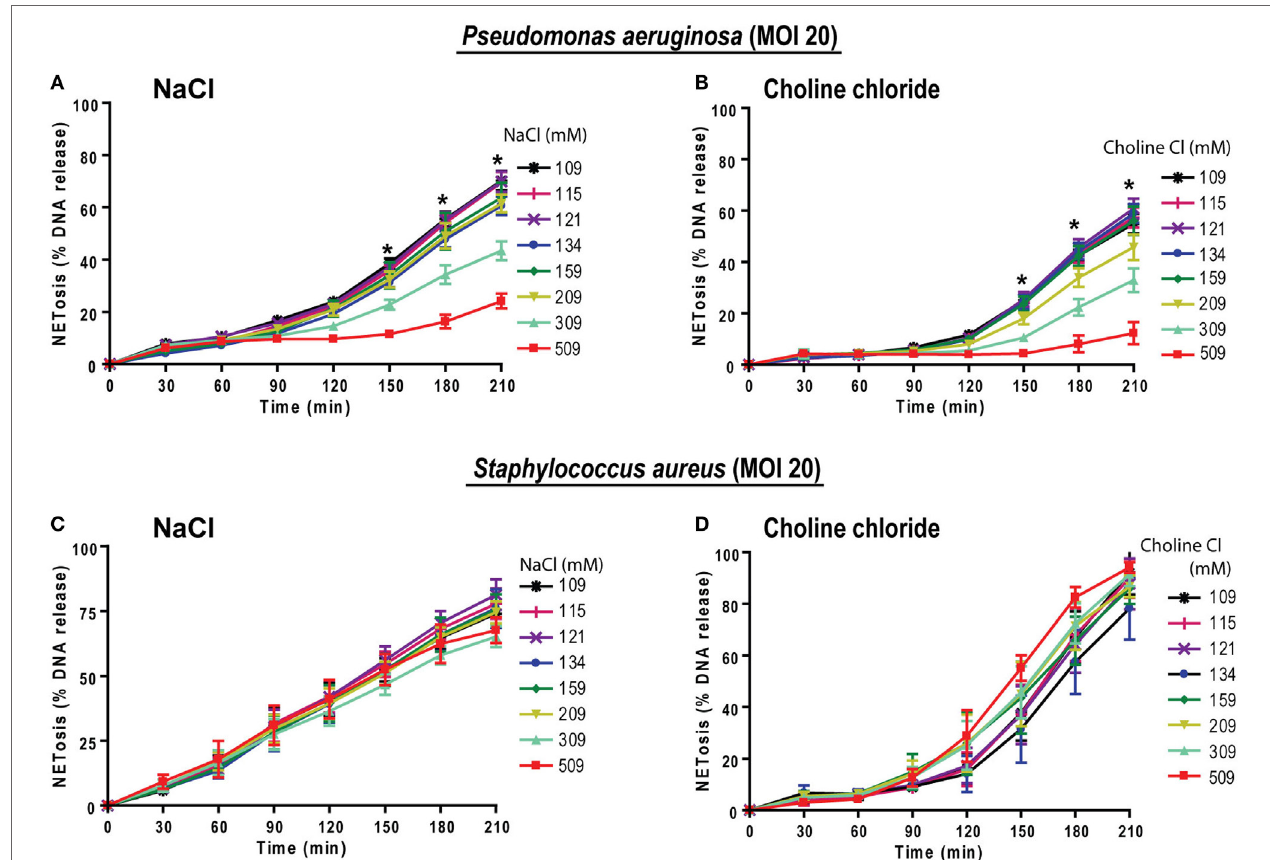
FigUre 9 | Increasing NaCl concentrations suppresses Pseudomonas aeruginosa -mediated NETosis. Neutrophils in different NaCl and choline chloride concentrations were activated either with P. aeruginosa or S. aureus (multiplicity of infection 20). (a,B) The % total NETosis induced by P. aeruginosa is suppressed during high NaCl or choline chloride concentrations compared to normal treatments (109 mM). (c,D) In contrast to P. aeruginosa -induced NETosis, S. aureus -induced NETosis was not suppressed by NaCl or choline chloride addition over 210 min ( n = 3; * p < 0.05; two-way ANOVA with Bonferroni’s multiple comparison post